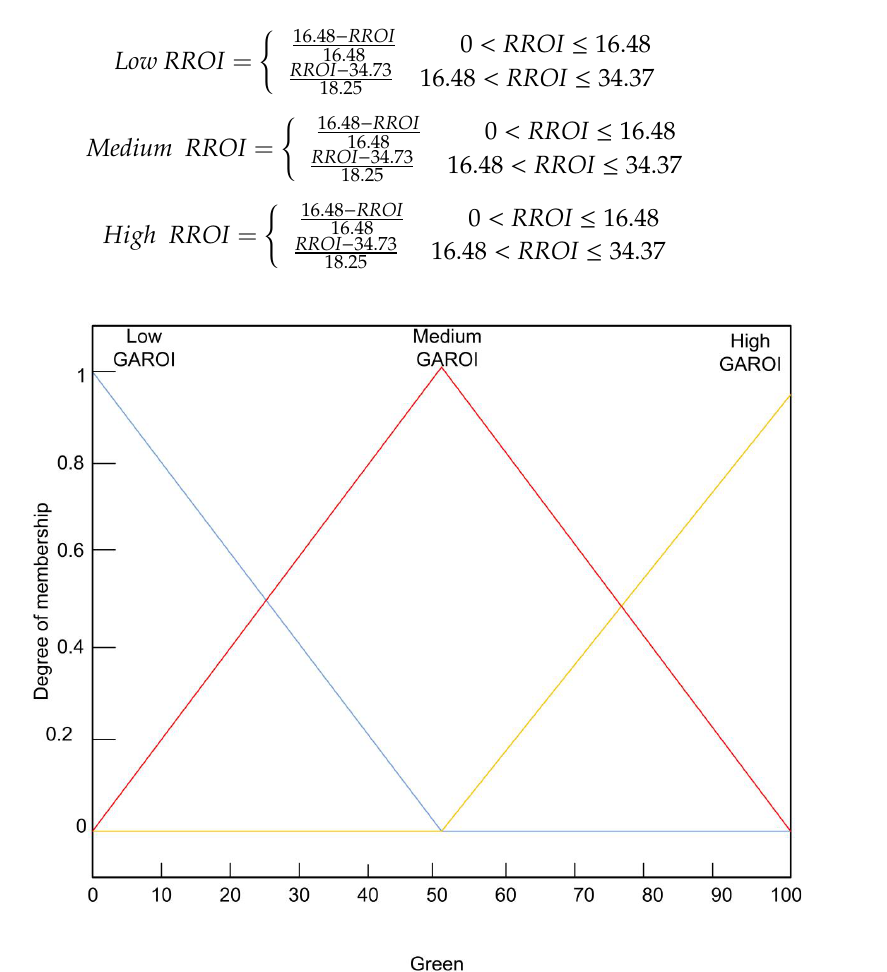
Figure 11 Figure 11. Membership functions of GAROI input.